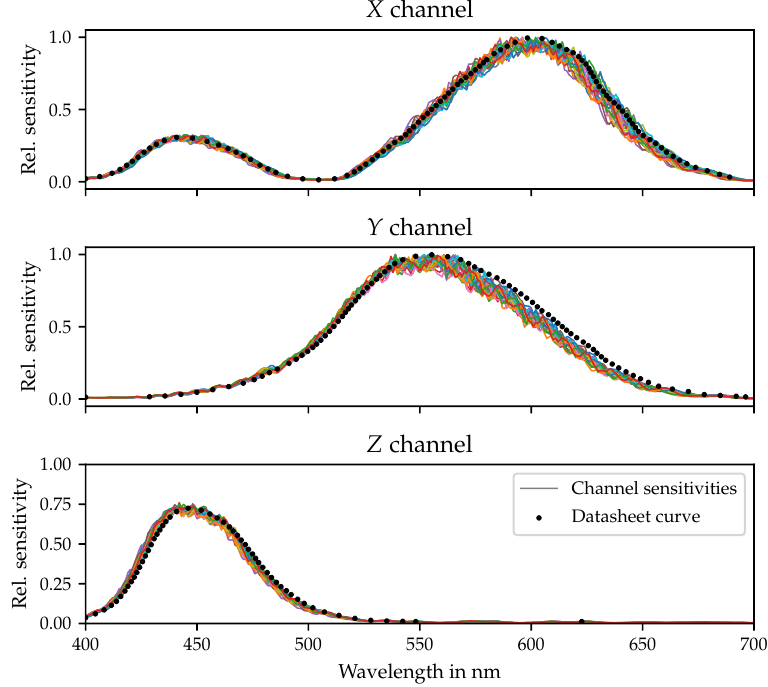
Figure 2. Spectral sensitivity curves (solid lines) of 24 color sensors of the same type, normalized to their sensitivity at 555nm in the Y channel and compared to their corresponding data sheet values (black dotted